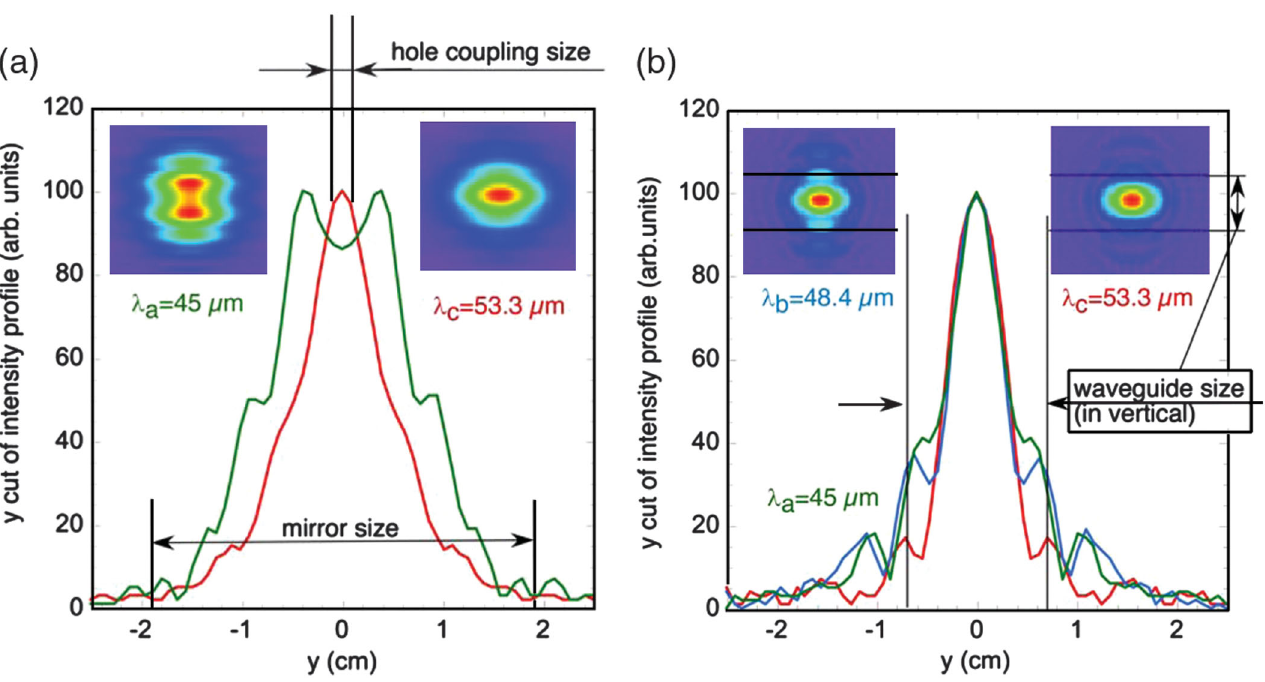
FIG. 6. (Color) (a) Numerical simulation in the case of spherical cavity: laser mode transverse profiles on the output mirror, for two different wavelengths. (b) Numerical simulation in the case of spherical cavity: laser mode transverse profiles on downstream waveguide entrance (point B in Fig. 1), for three different